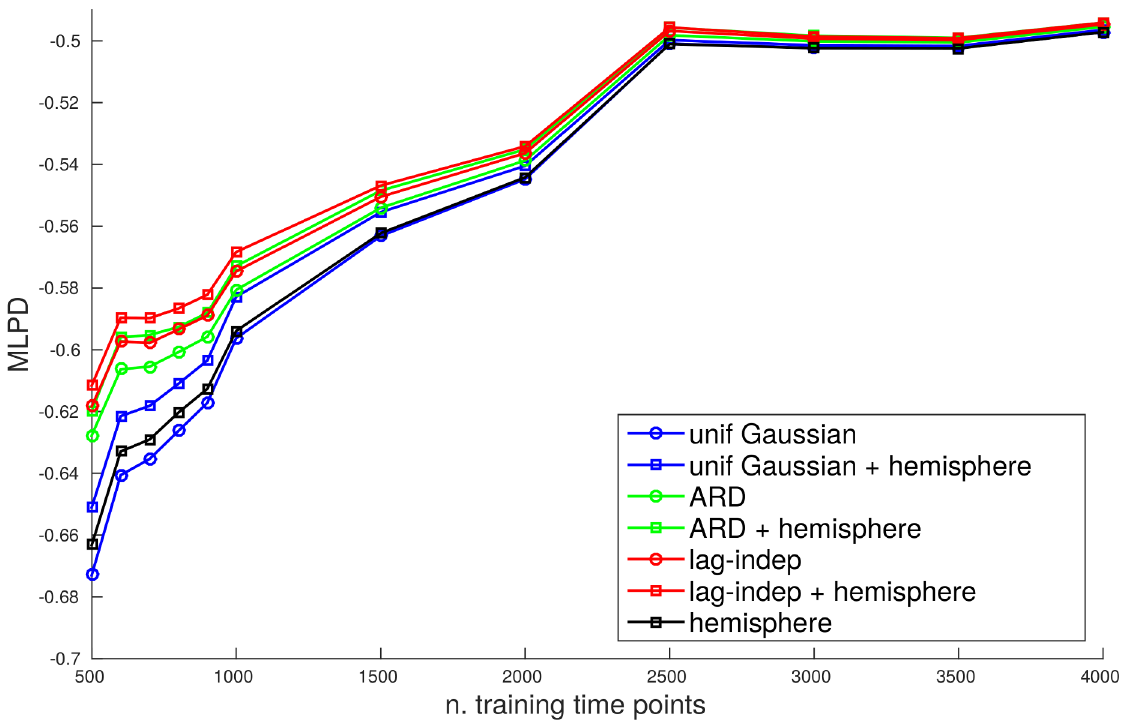
Fig 7. MLPD on the test set computed by multiple applications of GMEP under different structured priors and by varying the number of time points in the training set.